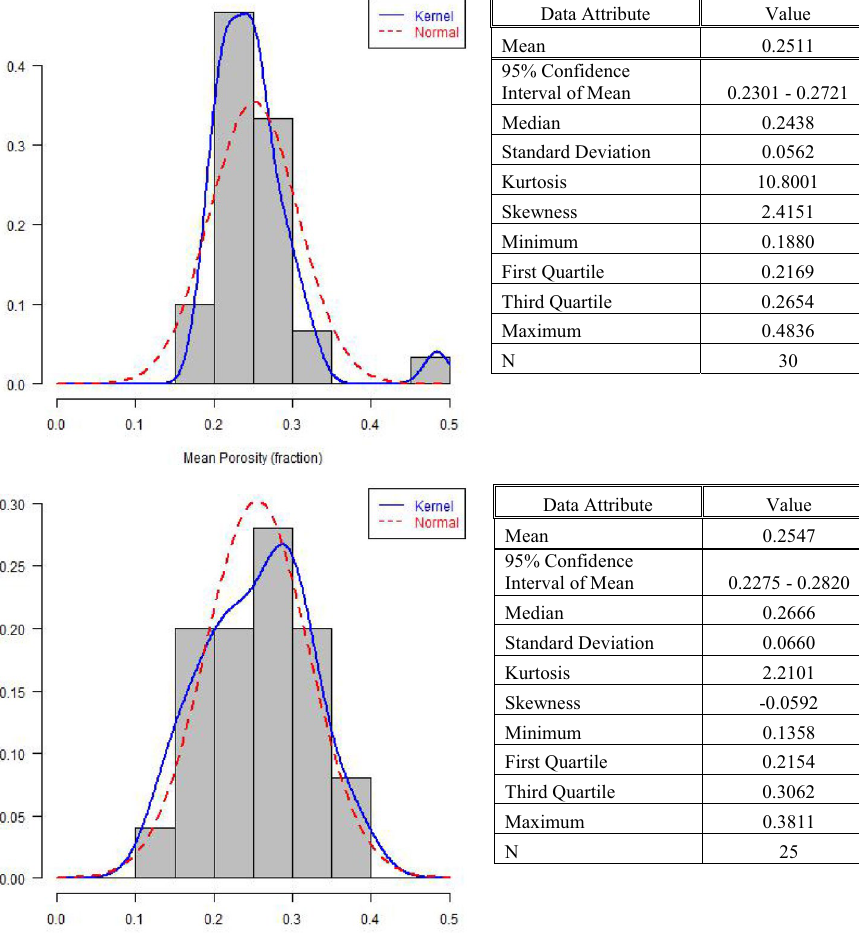
Fig. 16 Descriptive Statistics and Distributions of well-mean porosity values—Horizon